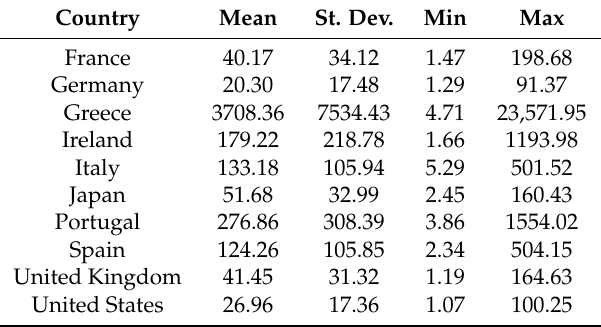
Table 1. Summary of statistics for the CDS spreads from 1 July 2006 to 31 December 2016. Means, standard deviations, minimum and maximum values are all expressed in basis points